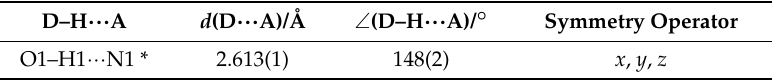
Table B6. Hydrogen bond geometry (Å, °) in compound mvanadpm .